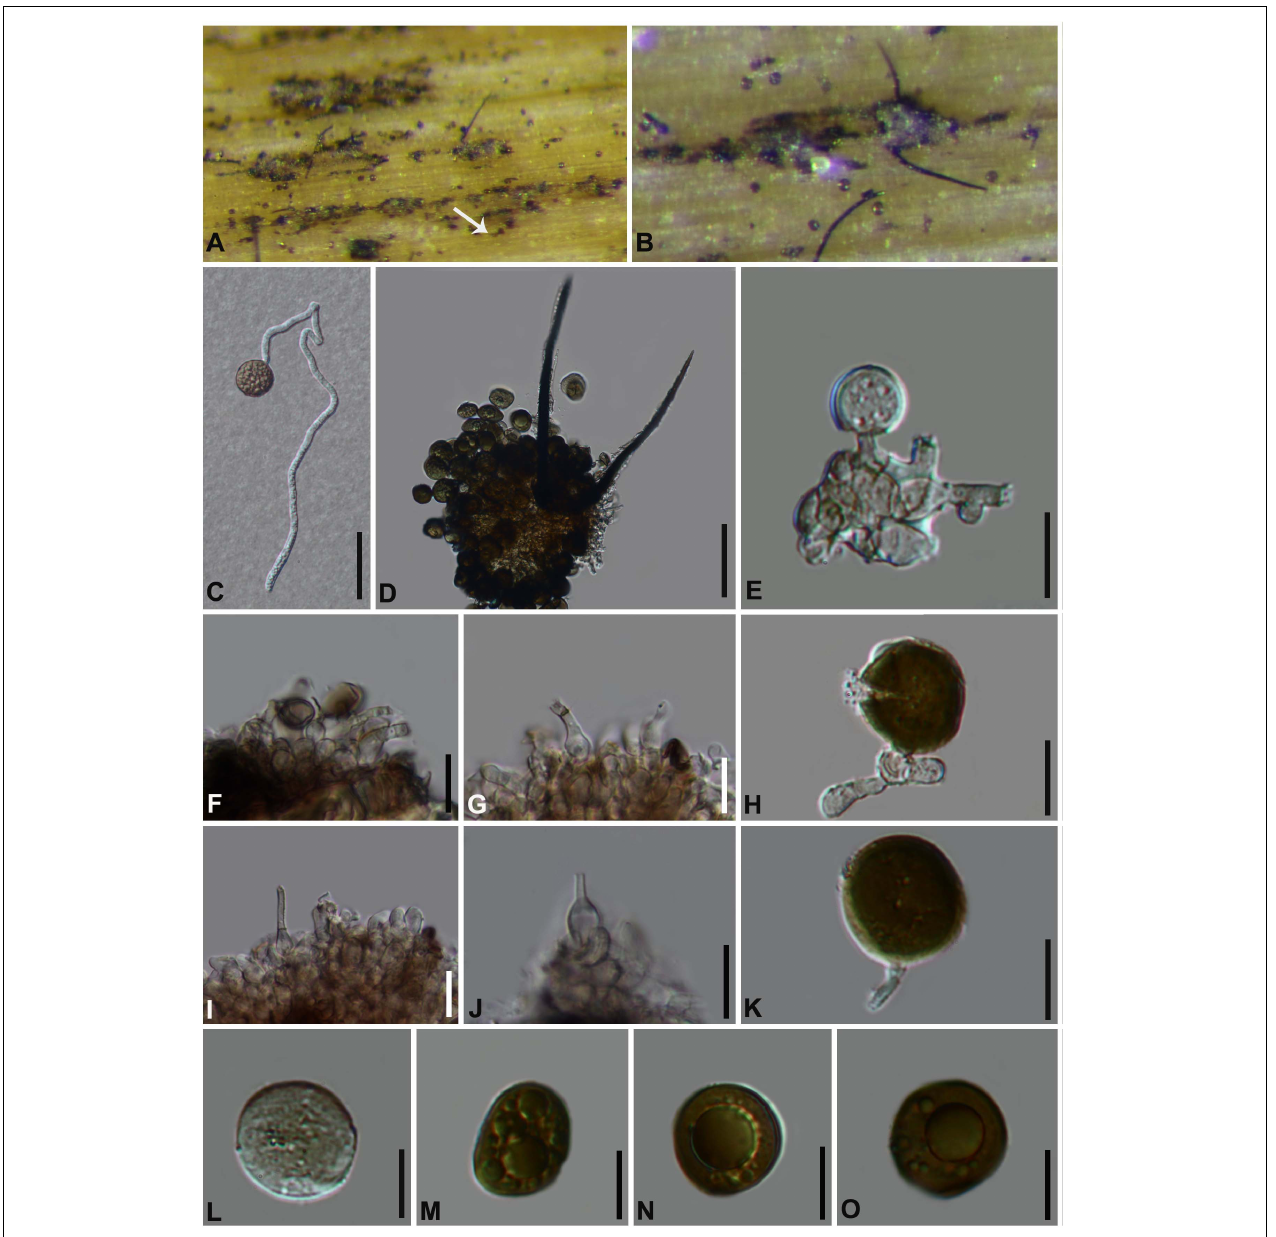
FIGURE 6 | Arthrinium garethjonesii (GZAAS 20–0117) (A,B) Appearance of sporodochia on bamboo host. (C) Germinating conidia. (D) Conidia with setae. (E–K) Conidiogenous cells and conidia. (L–O) Conidia. Scale bars: (C) = 30 µ m. (D) = 50 µ m. (E) = 20 µ m. (F,G) = 10 µ m. (H) = 5 µ m. (I,J) = 10 µ m. (K–O) = 5 µ